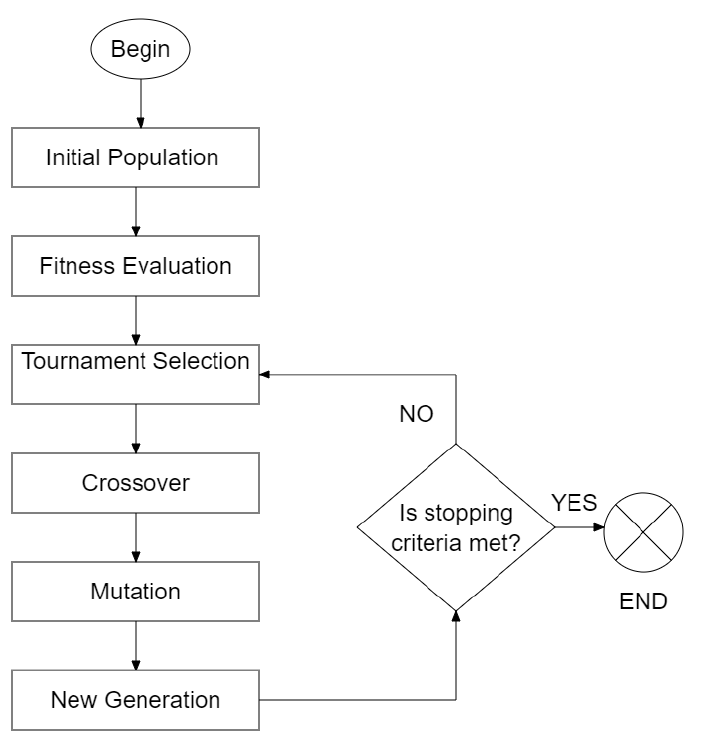
Figure 2. Flowchart of the implemented genetic algorithm (GA).